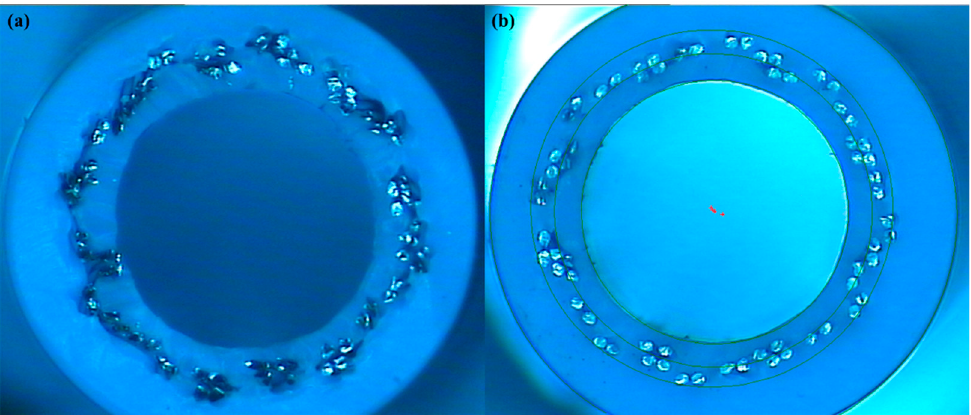
Figure 11. Surface morphology of cross-sections of braid-reinforced composite hollow fiber tubes with ( a ) uncoated and ( b ) coated stainless steel wires.